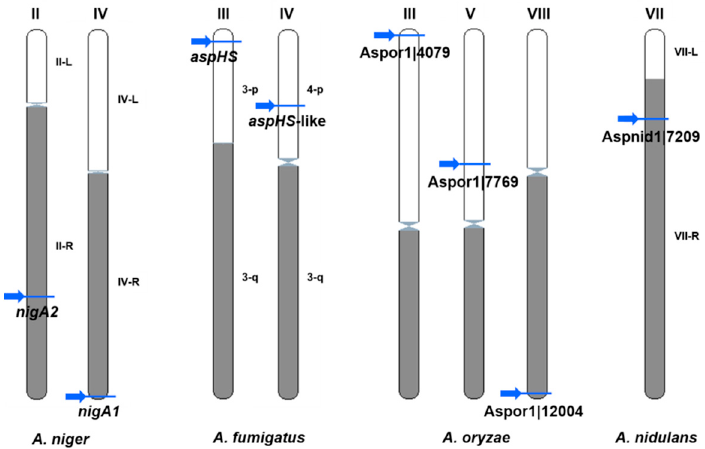
Figure 7. Chromosomal loci of aegerolysins in Aspergillus species with known karyotype. Aspergillus niger CBS 513.88 chromosome IV: nigA1 , and chromosome II: nigA2 ; A. fumigatus chromosome III: aspHS and chromosome IV, aspHS-like ; A. oryzae : chromosome III, Aspor1 | 4079, chromosome V, Aspor1 | 7769, and chromosome VII: Aspor1 | 12004; and A. nidulans chromosome VIII: Aspnid1 | 7209. Arrows, position of aegerolysin genes on chromosomes. Data were obtained from Ensembl Fungi (EMBL-EBI) [47] and CADRE [48].